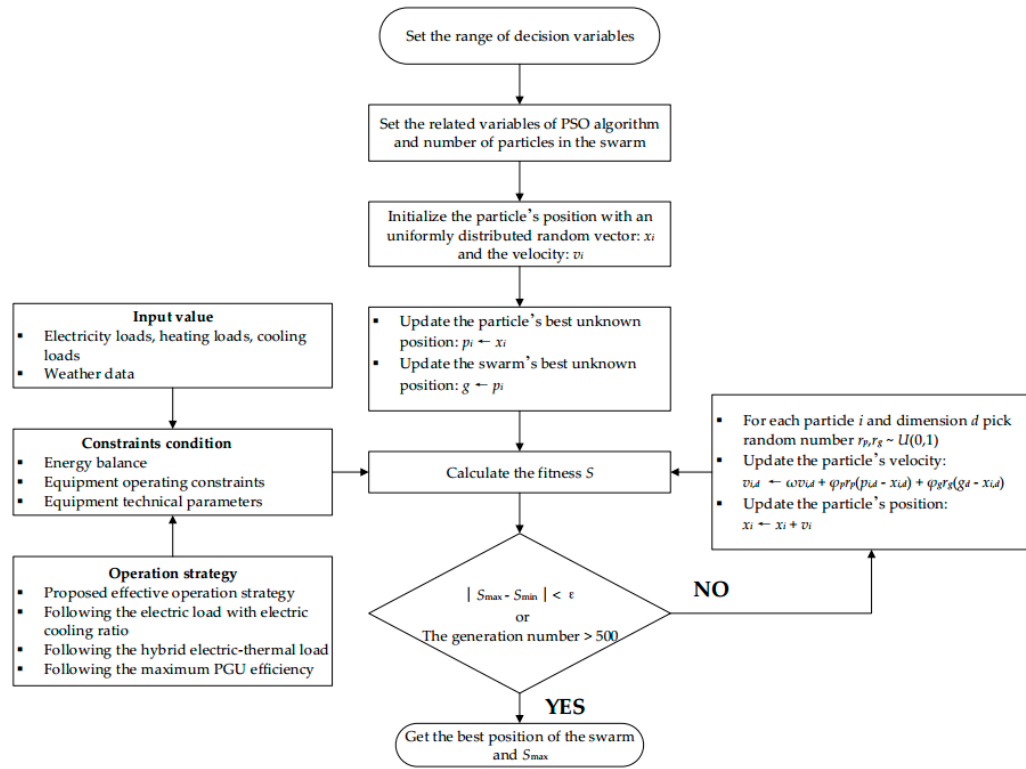
Figure 2. The flow chart of the optimization method based on the particle swarm optimization. Table 1. The range of variations of the decision variables.